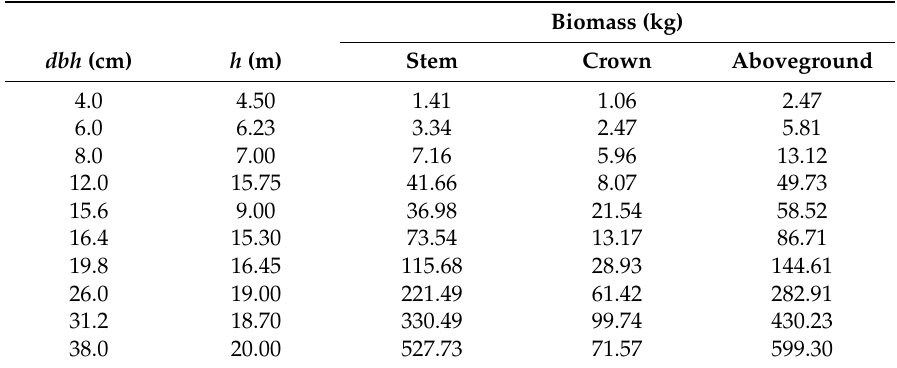
Table 2. Observed biomass data for model validation gathered from